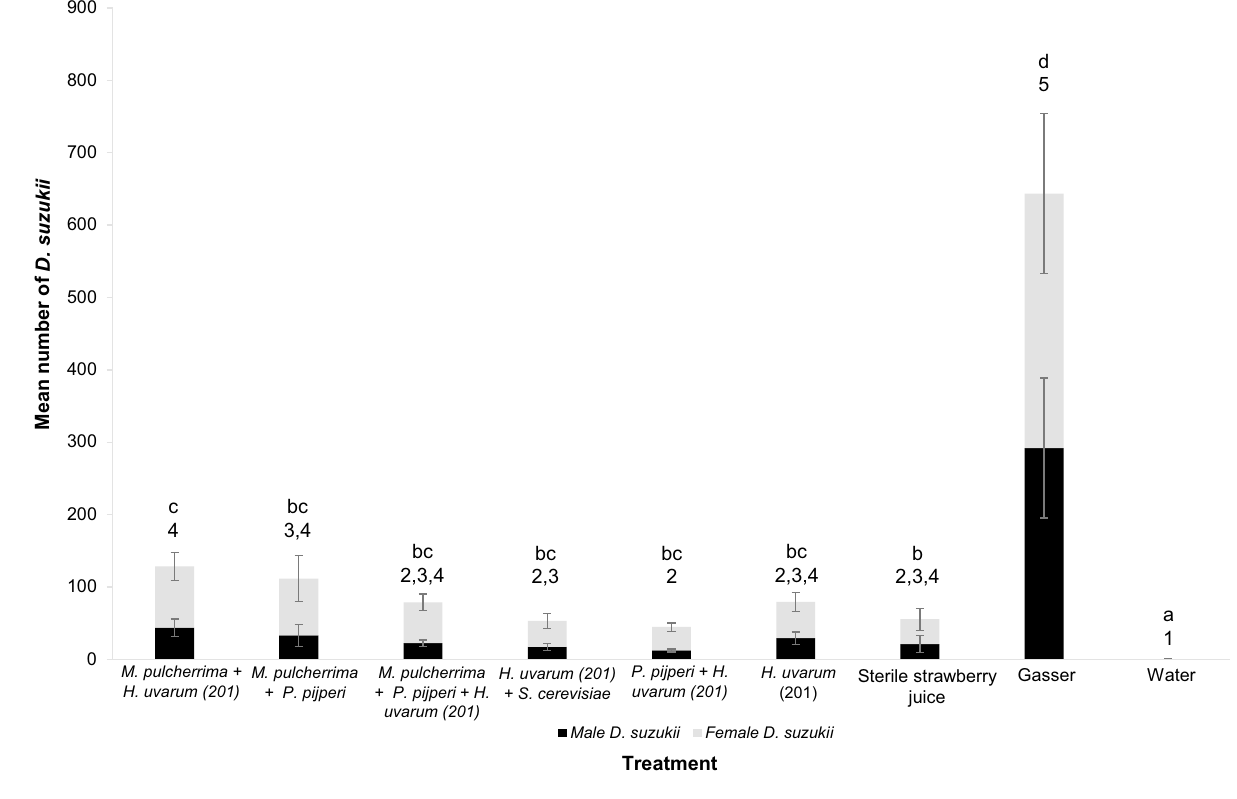
Figure 5. Mean numbers (± SE) of D. suzukii caught in field traps with various combinations of yeast metabolic volatiles (not identified) with H. uvarum (201), sterile strawberry juice, water and commercial Gasser-lure controls. Combinations were created by adding equal proportions after growth in strawberry juice (N = 14 except M. pulcherrima + P. pijperi N = 13). There was a significant effect of bait type on D . suzukii capture (linear model Δ deviance = 21,352, df = 8, P < 0.001; Kruskal–Wallis, chi-squared = 66.98, df = 8, P = 1.95 –11 ). Two post- hoc analysis methods were employed: letters above bars connect treatments that are not significantly different using Dunn’s comparisons with Benjamini–Hochberg adjusted P values and numbers above bars connect treatments with overlapping 95% confidence intervals calculated from Estimated Marginal